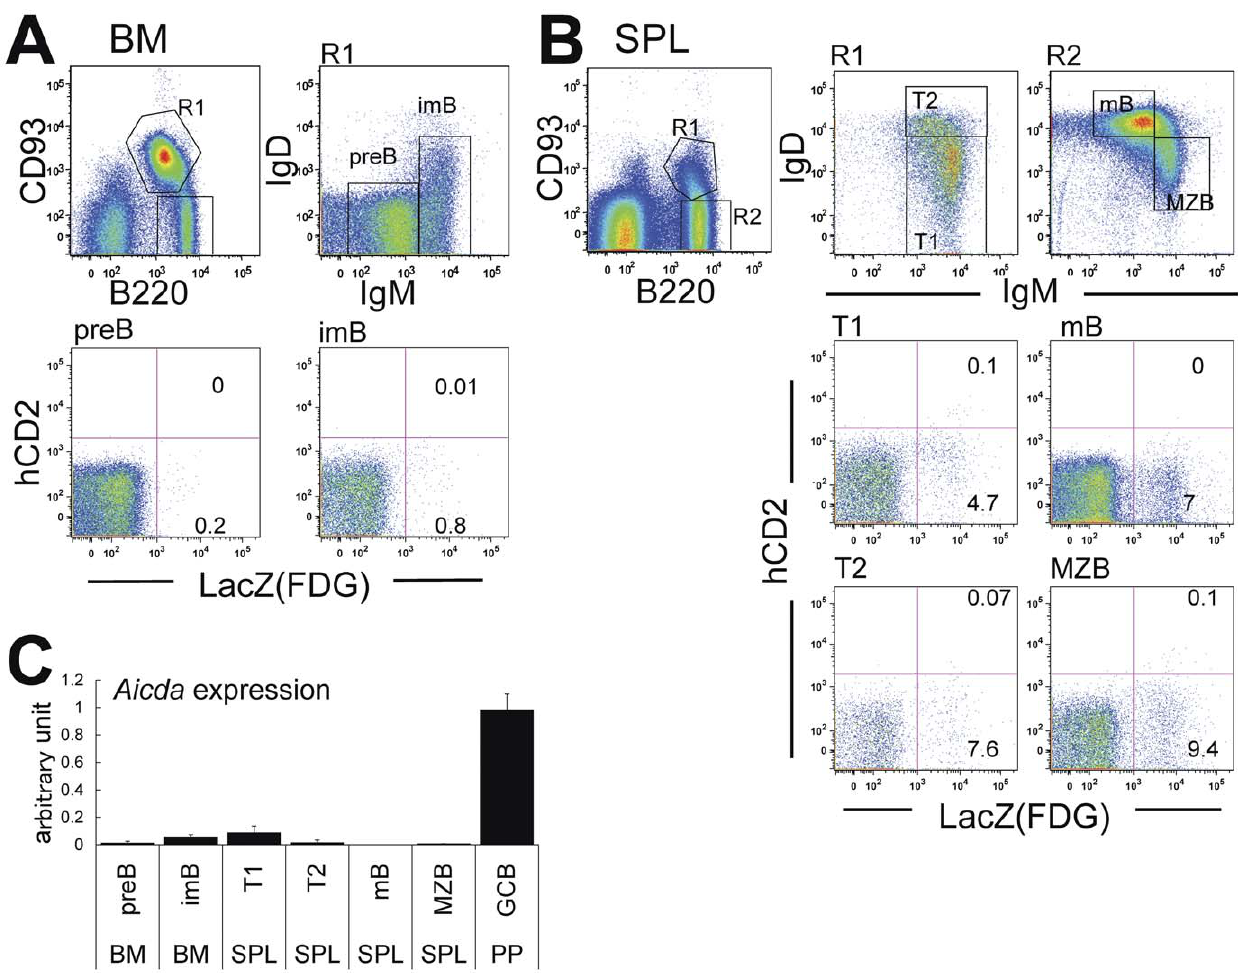
Figure 2. Low-level Aicda expression visualized in immature B cells. (A) Bone marrow (BM) cells of 7-week-old Aicda-cre/R26R mice were stained by the indicated markers. The corresponding gate for each panel is indicated. Numbers in each quadrant indicate the percentage of gated cells. (B) Aicda-cre/R26R spleen (SPL) cells were stained for the indicated markers. Gated areas are indicated in the top panels. (A)(B) Mean values and standard deviations of the percentage of LacZ + cells in three 7 , 8-week old mice were as following: preB=0.33 6 0.16, imB=1.03 6 0.23, T1=4.96 6 1.35, T2=7.74 6 2.99, mB=7.96 6 2.69, MZB=6.54 6 2.97. (C) Aicda expression is shown for each B-cell stage detected by RT-PCR; values were normalized to the Gapdh expression. Expression levels are presented relative to the average signal of germinal center B cells. The data represent the average of three independent experiments with standard deviation. R1, region 1; R2, region 2; preB, premature B cell; imB, immature B cell; T1, transitional B cell 1; T2, transitional B cell 2; mB, mature B cell; MZB, marginal zone B cell; GCB, germinal center B